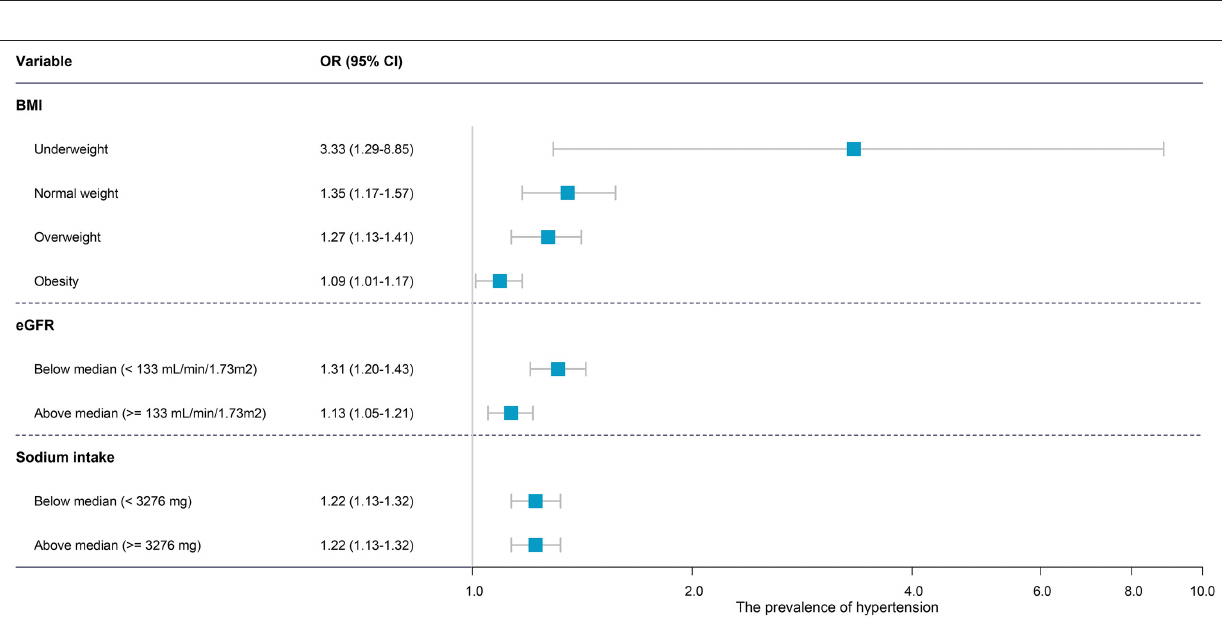
FIGURE 3 | Forest plot of the subgroup analysis of the association between waist circumference and (pre) hypertension. The association was adjusted for body mass index, age, sex, race/ethnicity, education levels, diabetes history, smoking status, alcohol consumption, height, and administration of anti-hypertensive medications. OR, odds ratio; CI, confidence